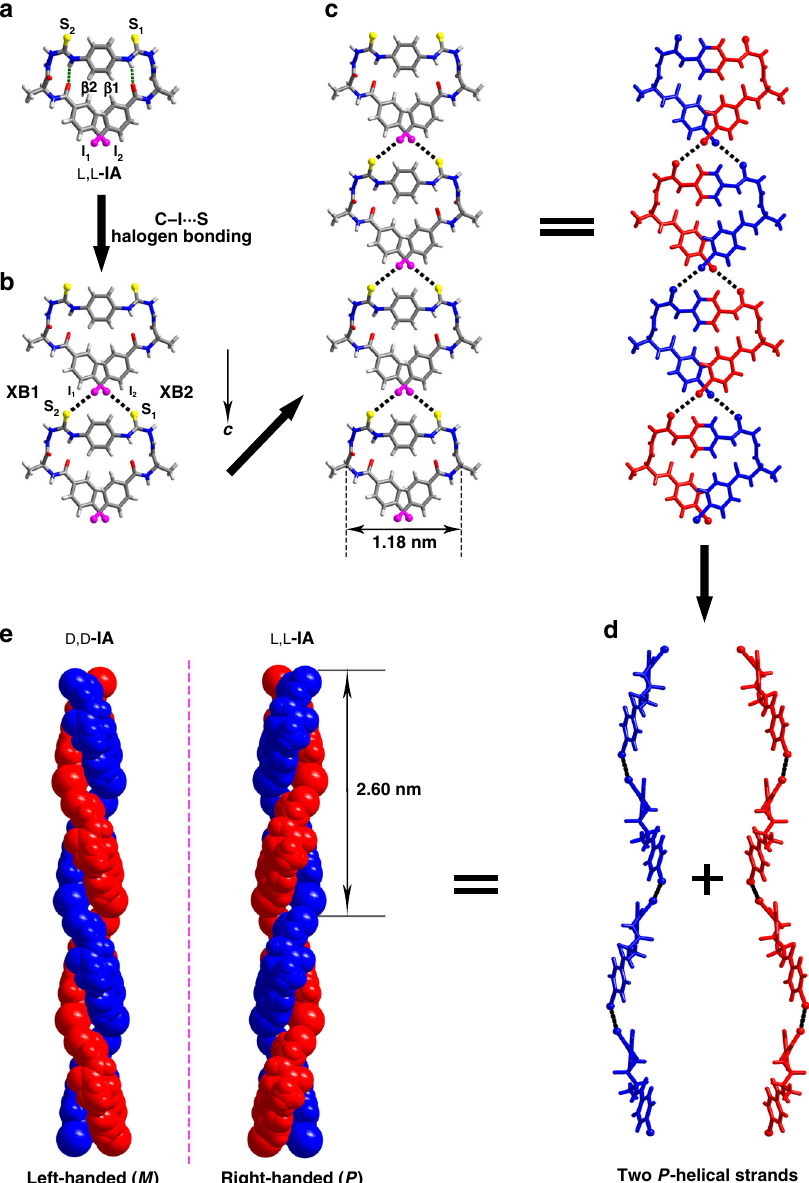
Fig. 2 Single-handed supramolecular double helix from L,L- IA and D,D- IA . a X-ray crystal structure of L,L- IA showing cis -form with β -turn at each side. Dashed green lines highlight the IHBs that form the β -turn structures β 1 and β 2 . b Crossed double C − I···S halogen bonds between two adjacent cis -form L, L- IA molecules. Dashed black lines highlight two C − I···S halogen bonds XB1 and XB2 . c 1D superstructure of cis -form L,L- IA molecules through C − I···S halogen bonding along c -axis. d Two P -helical strands in 1D superstructure of L,L- IA . e M -double and P -double helices formed, respectively, from the enantiomeric D,D- IA and L,L- IA . For clarity reasons, one side in the bilateral D,D- IA and L,L- IA molecules is depicted in blue, while the other side is depicted in